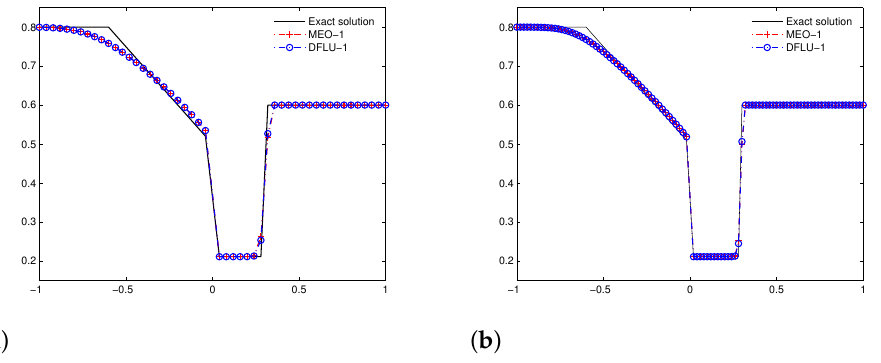
Figure 3. Example 1: Numerical solutions computed by the MEO-1 and DFLU-1 with the different meshes. ( a ): ∆ x = 1/25; ( b ): ∆ x =